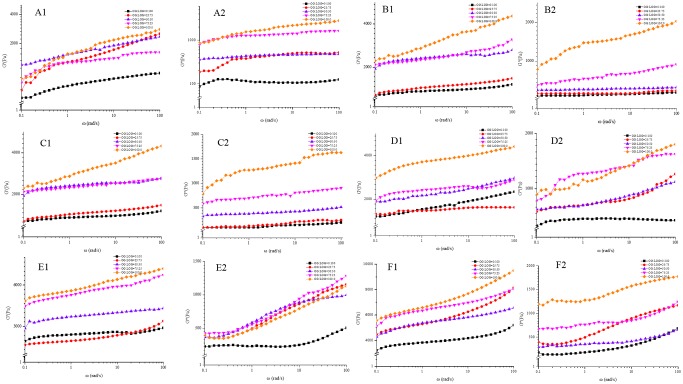
The frequency sweep curves (G′ and G″) of β-glucan mixed gels prepared at different pressure with varying total concentrations and ratios.(A) Total concentration of 8% under 500MPa. (B) Total concentration of 15% under 200MPa. (C) Total concentration of 12% under 400MPa. (D) Total concentration of 10% under 500MPa. (E) Total concentration of 15% under 400MPa. (F) Total concentration of 12% under 500MPa.